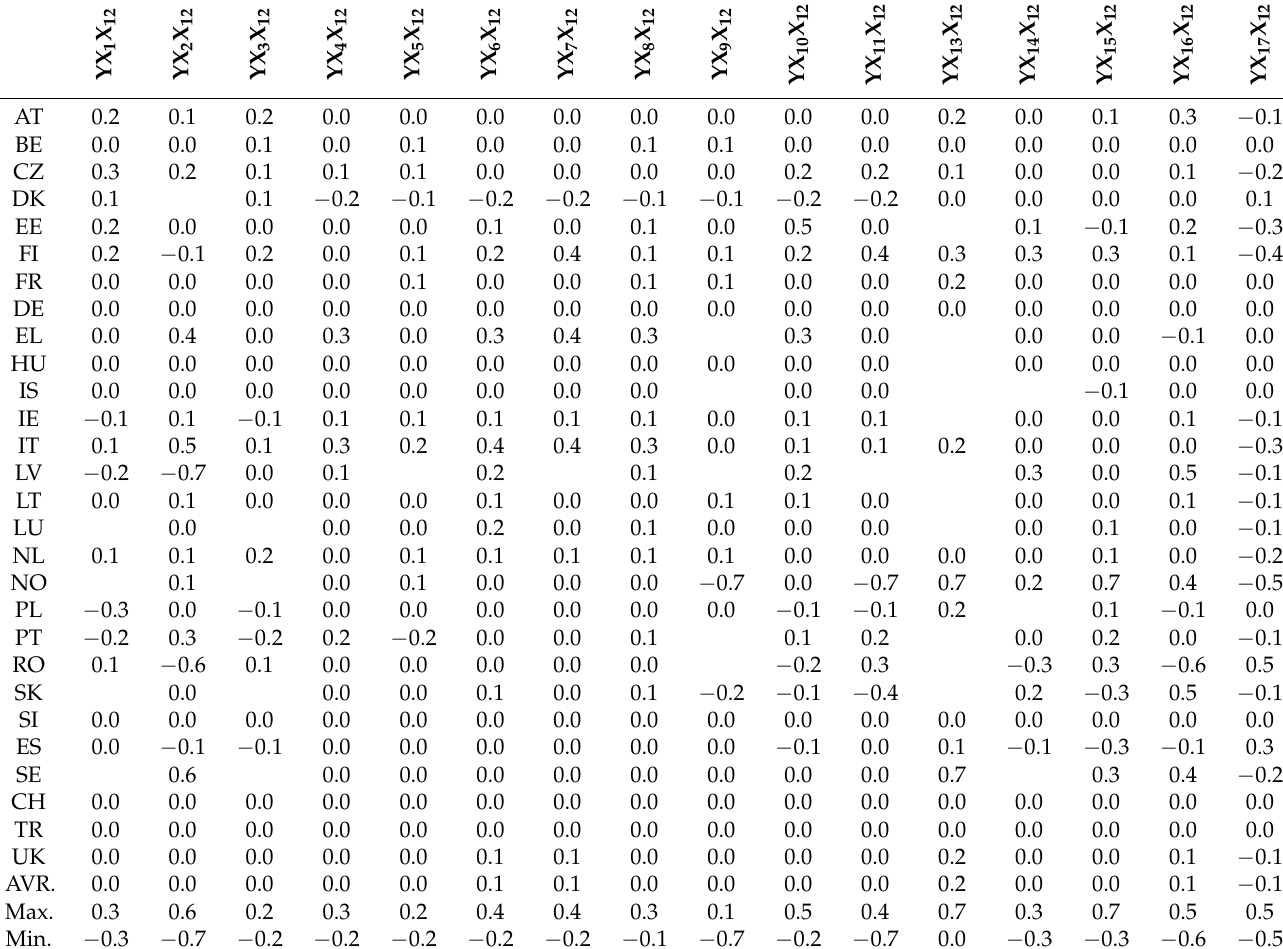
Table 7. Tri-dimensional synergy—YX i X 12 .